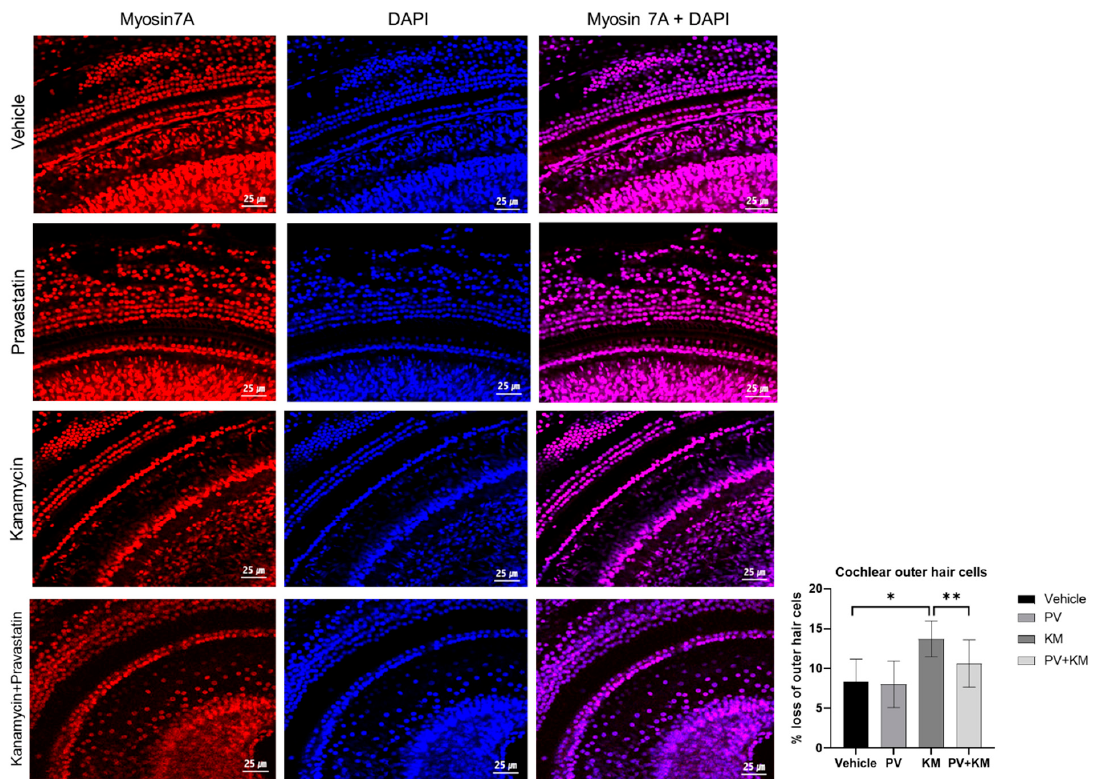
Figure 3. Cochlear whole-mount staining of each group. The KM group showed loss of outer hair cells vs. the control group. The PV + KM group demonstrated less loss of outer hair cells than the KM group (red: myosin 7a-positive cells, blue: DAPI-positive cells, purple: myosin 7a and DAPI- positive cells; * p < 0.05, Mann–Whitney U test between the control and KM groups, ** p < 0.005, Mann–Whitney U test between the KM and PV + KM groups).